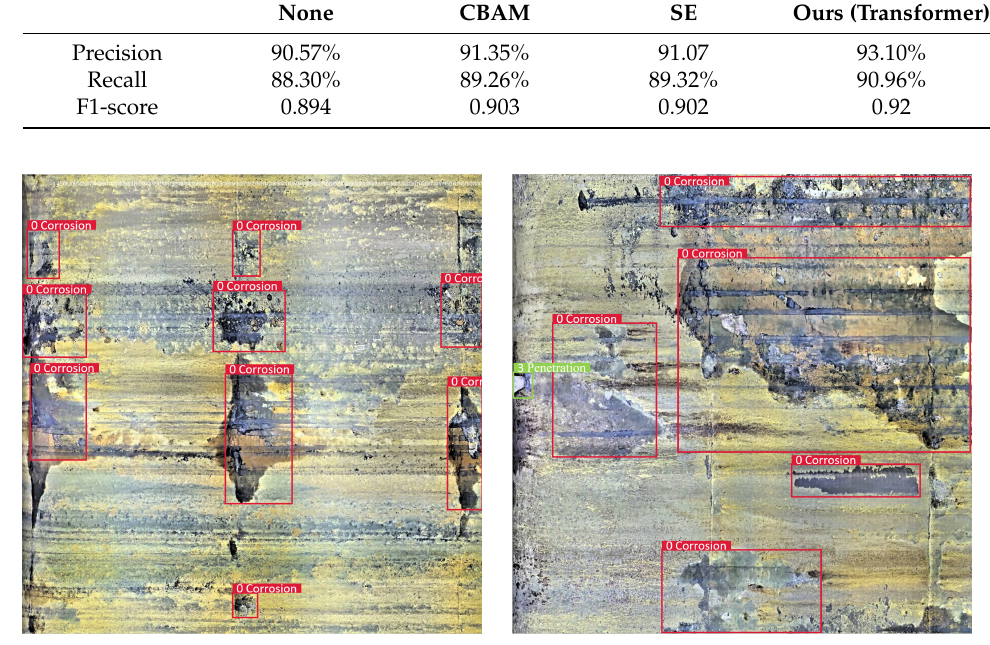
Figure 17. Detection result on the distillation pipeline